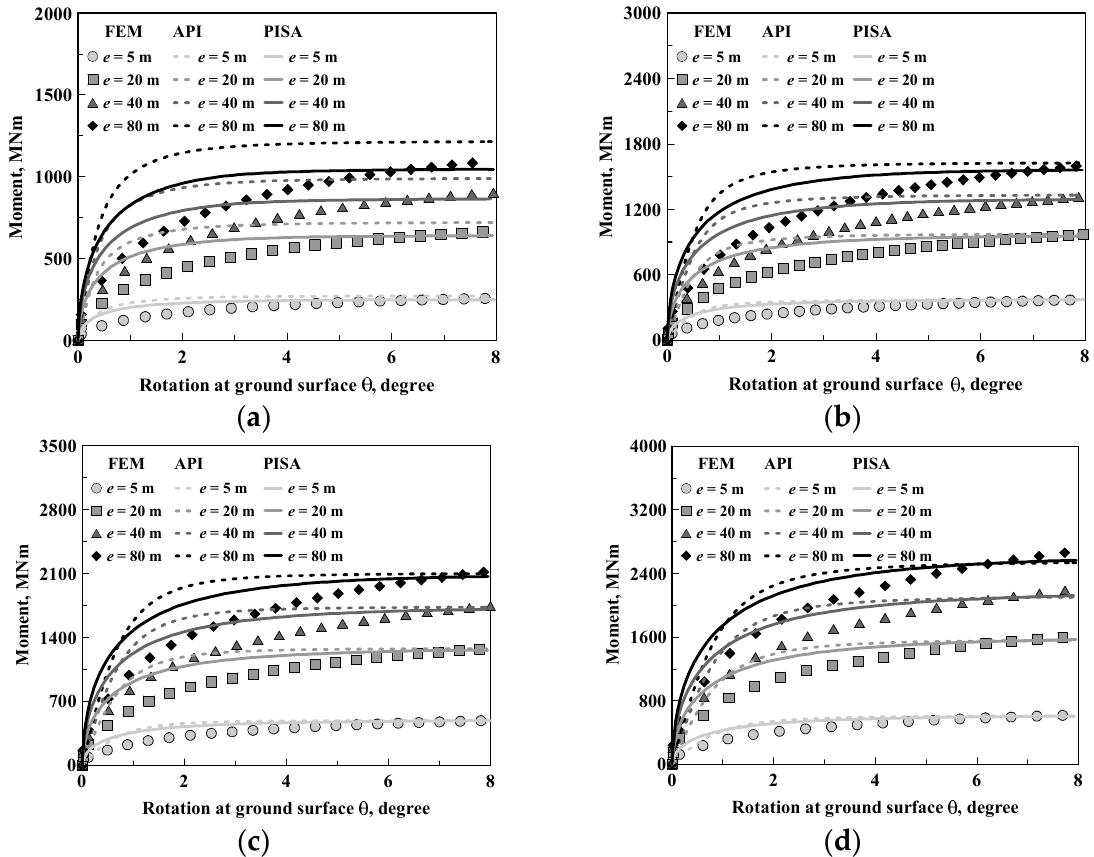
Figure 15. Moment–rotation curves at the ground surface in 40% relative density sand: ( a ) D = 4 m, ( b ) D = 6 m, ( c ) D = 8 m, ( d ) D = 10 m.